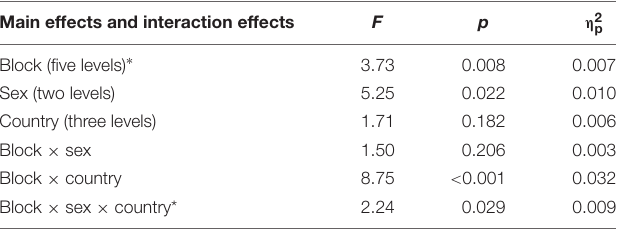
TABLE 1 | Summary of the mixed ANOVA including the factors IGT block (within), sex (between), and country (between) on IGT net score.